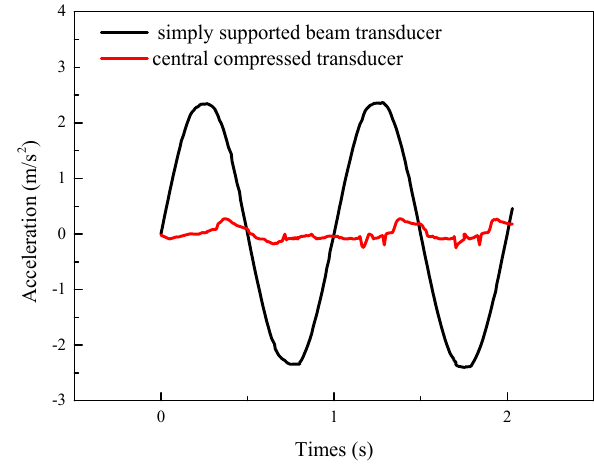
Figure 16. The waveform of different models at 1